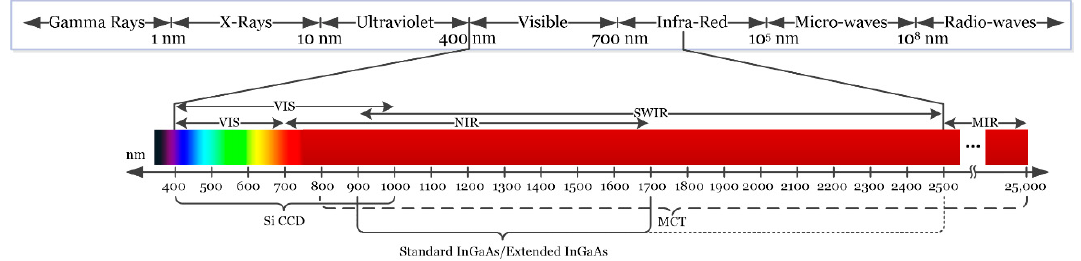
Figure 2. Electromagnetic spectrum. HSI is commonly employed between the visible and the medium ‐ infrared range.